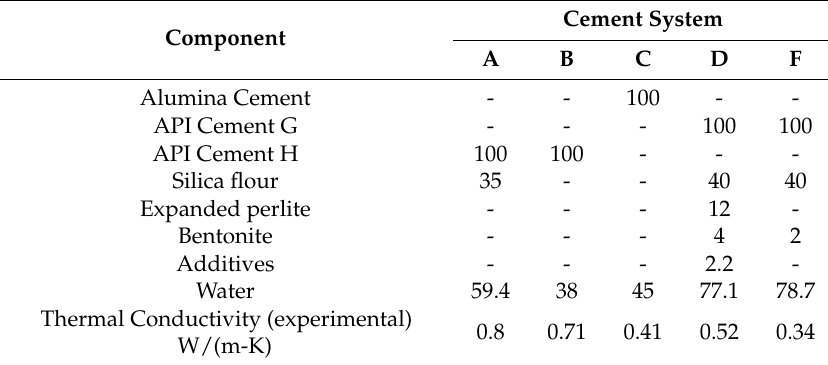
Table 4. Cements composition (in percentage by mass) (after [13]).